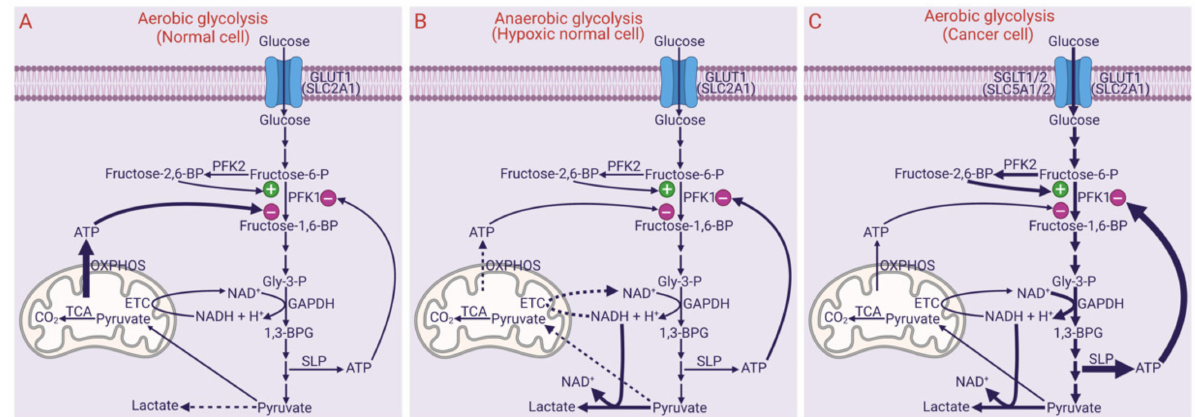
Figure 1. Differential features of aerobic glycolysis in normal cells ( A ), anaerobic glycolysis in normal cells ( B ), and aerobic glycolysis in cancer cells ( C ). PFK1, phosphofructokinase-1; PFK2, phosphofructokinase-2; Gly-3-P, glyceraldehyde-3- phosphate; 1,3-BPG, 1,3-bisphosphoglycerate; TCA, tricarboxylic acid cycle; ETC, electron transport chain; OXPHOS, oxidative phosphorylation wherein phosphorylation of ADP is coupled to oxidation of NADH and FADH 2 , thus generating ATP; SLP, substrate-level phosphorylation wherein phosphorylation of ADP is coupled to the hydrolysis of high-energy substrates 1,3-bisphosphoglycerate and phosphoenolpyruvate, thus generating ATP; GLUT1, glucose transporter 1; SGLT, sodium-coupled glucose transporter; SLC, solute